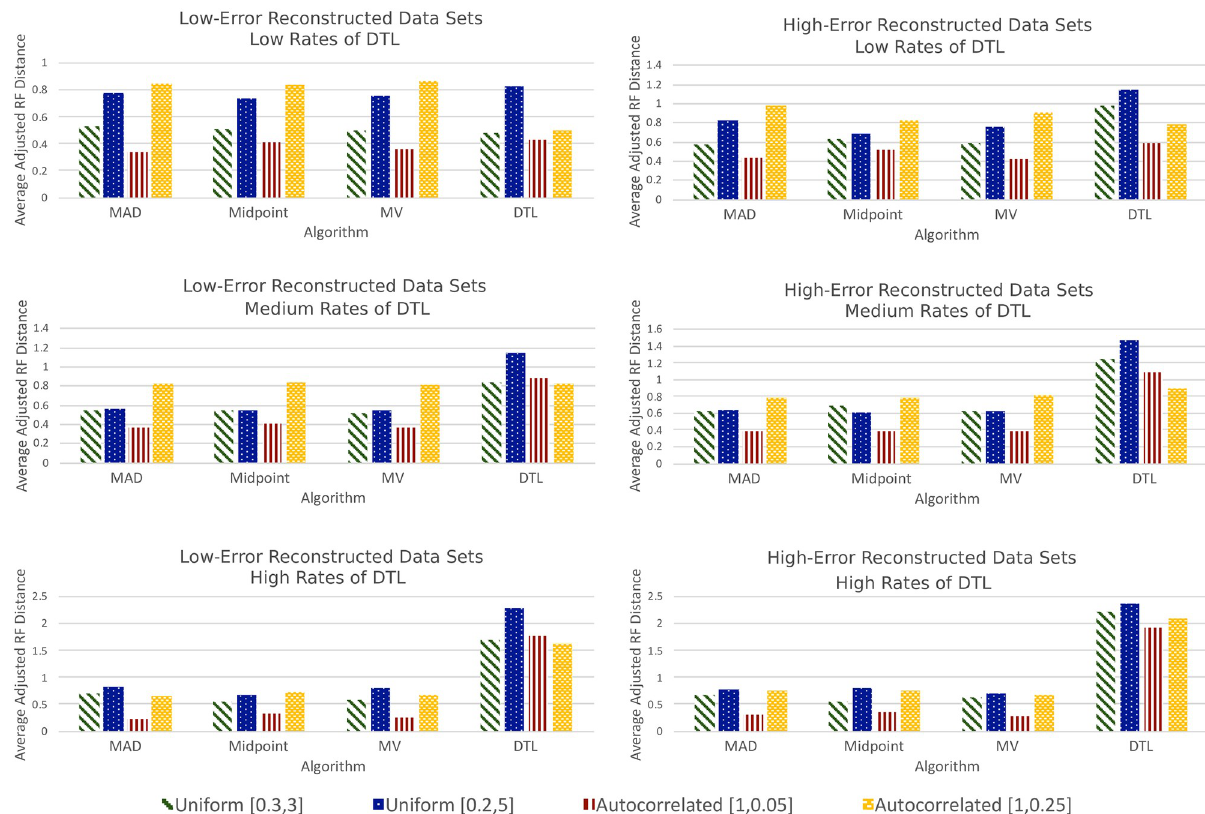
Fig 5. Results on reconstructed baseline data sets. The plots on the left show, for each rooting method and each of the 12 low-error reconstructed baseline data sets, the average adjusted RF distances for the reconstructed gene trees compared to their corresponding true gene trees. The plots on the right display analogous information for the 12 high-error reconstructed baseline data sets. Note that the RF distances displayed in these plots measure both tree reconstruction error and rooting error. Corresponding normalized RF distances are reported in Tables A3 and A4 in S1 Appendix.